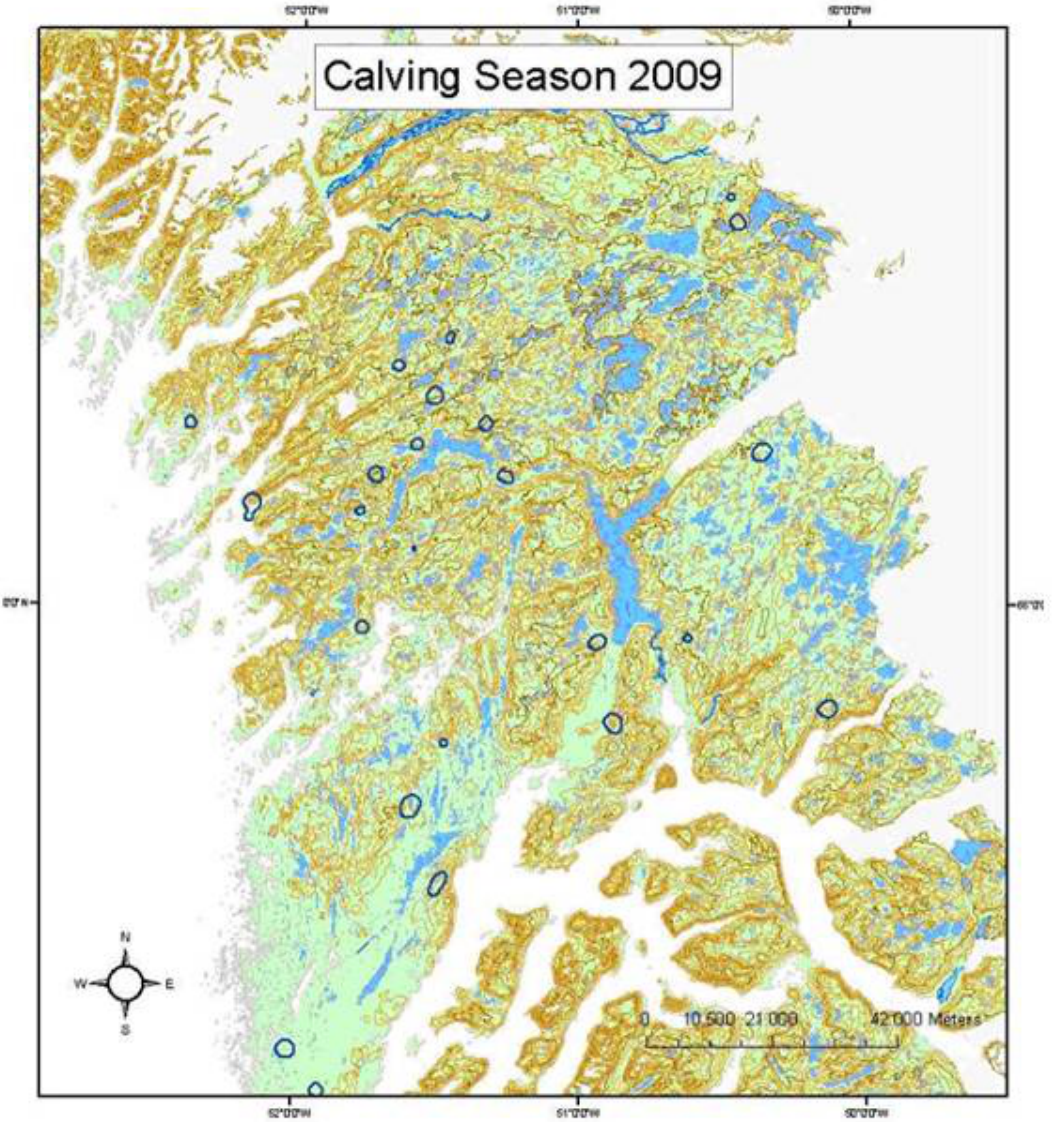
Fig.1. Individual core areas of collared caribou during the calving season 2008. Please note that the title is wrong – the correct year is